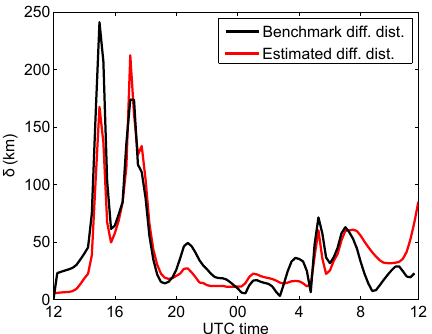
Figure 10. Differential distance between the successive source points on the isochrone source line corresponding to δt = 0.25h. The black line shows the benchmark and the red line shows the ap- proximated time series that is calculated by the local FTLE formula ( x )) | v ( x ,t 1 ,t 2 )δt | . The backward integration time as exp ( | T | σ T [ t 1 ,t 2 ] for calculations of the flow maps is T = 24h and the interroga- tion window is 12:00UTC 29 September to 12:00UTC 30 Septem- ber